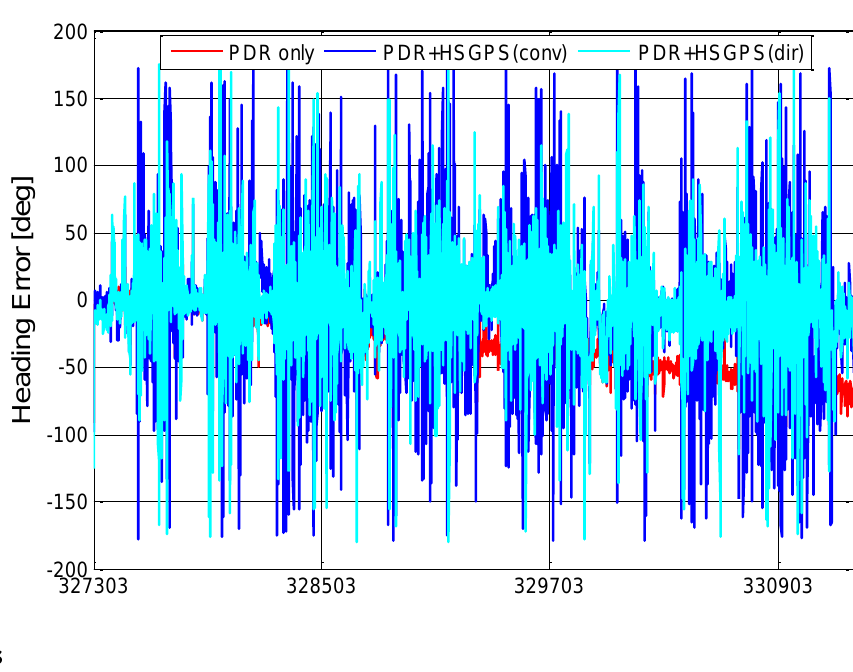
Figure 14. Interpolated heading